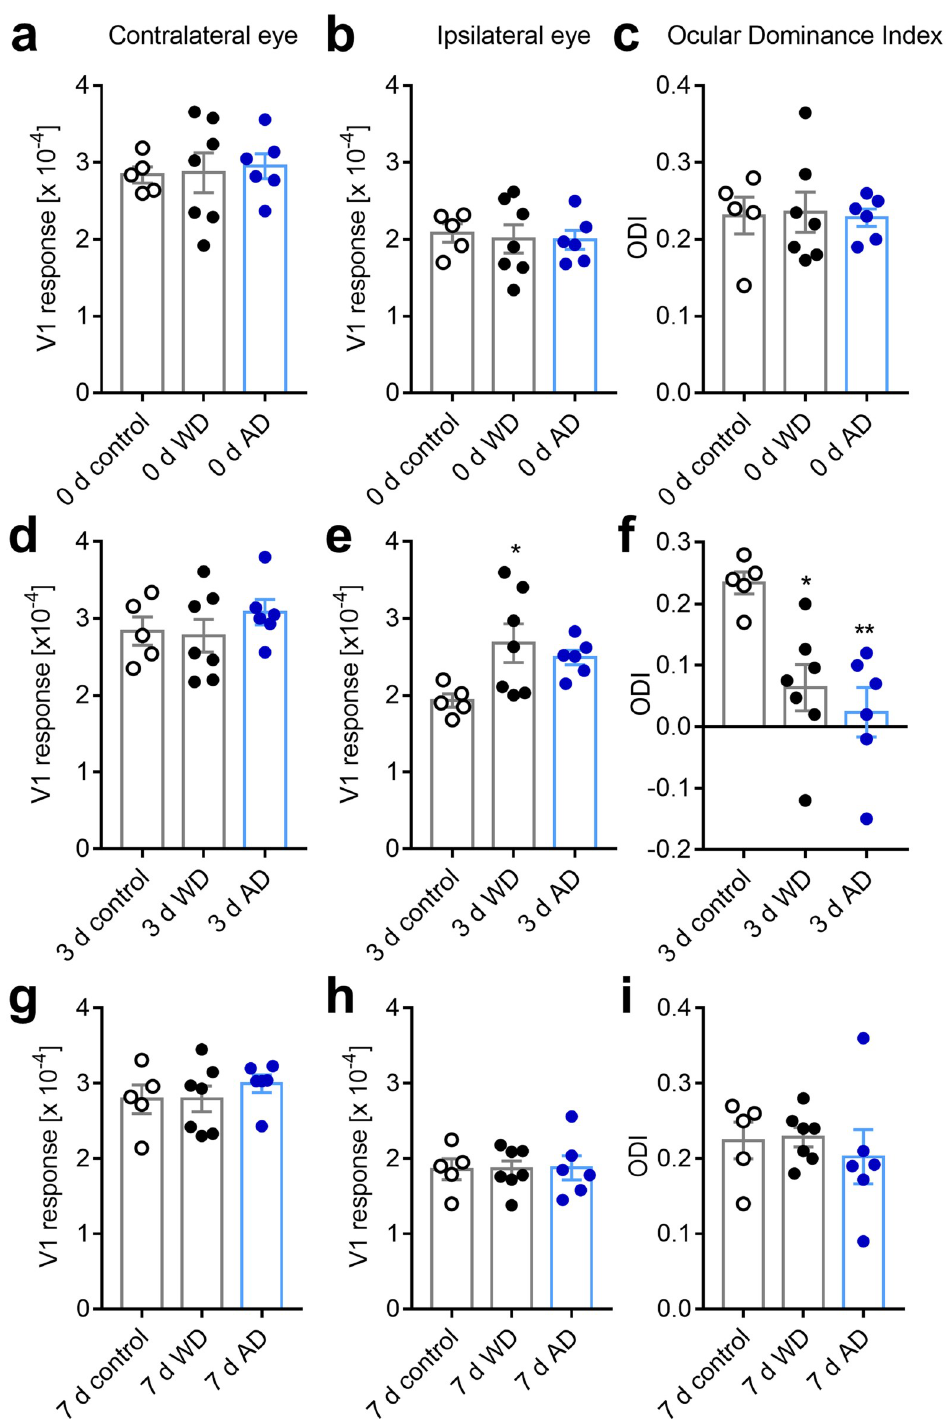
Fig 4. Both WD or AD induce an ODI shift compared to normal control mice. ( a, b ) V1 responses evoked by visual stimulation of either the contra or ipsilateral eye immediately after WD (n = 7) or AD (n = 6) were indistinguishable from values obtained in normal control mice (n = 5). ( c ) Hence, directly after WD or AD there was no alteration of the ODI. ( d ) After 3 days of either WD or AD V1 responses elicited by contralateral eye stimulation was not different from control values. ( d ) However, V1 activity evoked by stimulation of the eye ipsilateral to the recorded hemisphere was increased 3 days after WD or AD compared to control levels. ( f ) Thus, at this time point there was a significant shift of